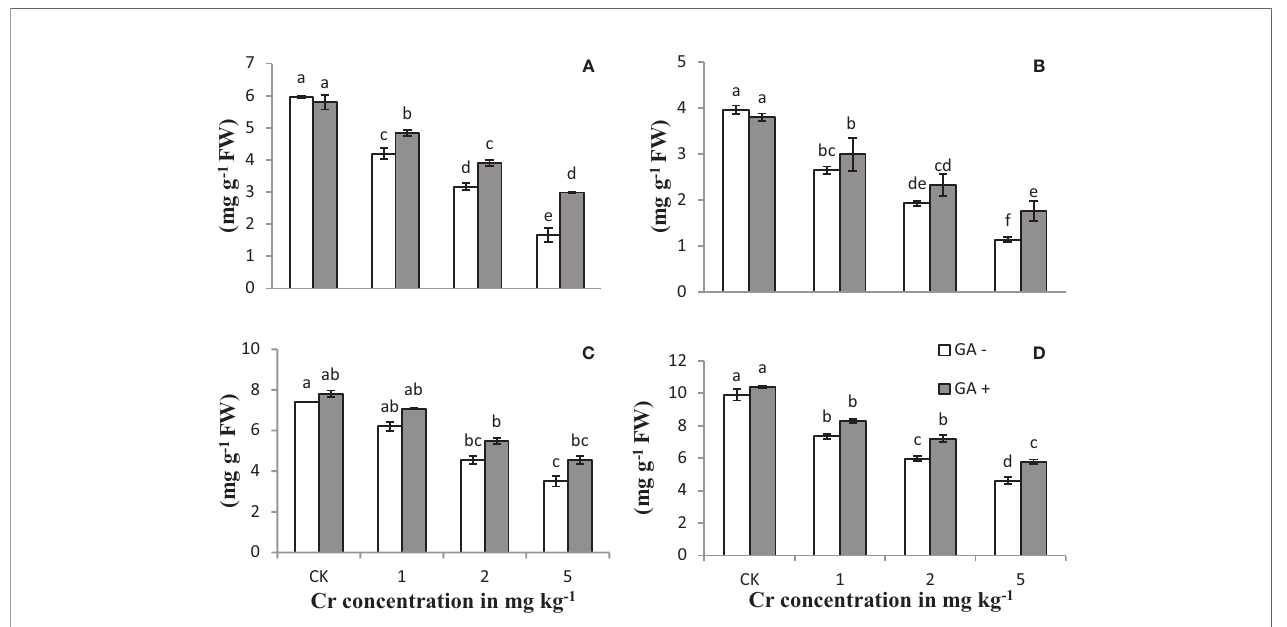
FIGURE 1 | Effect of Cr and GA on chlorophyll a (A) , chlorophyll b (B) , total chlorophylls (C) and carotenoids (D) in Sun fl ower grown in soil with increasing Cr concentrations (0, 1, 2 and 5 mg kg − 1 ) and GA (0 and 5mM). Values are demonstrated as means of fi ve replicates along with standard deviation. Different small letters indicate that values are signi fi cantly different at P < 0.05.